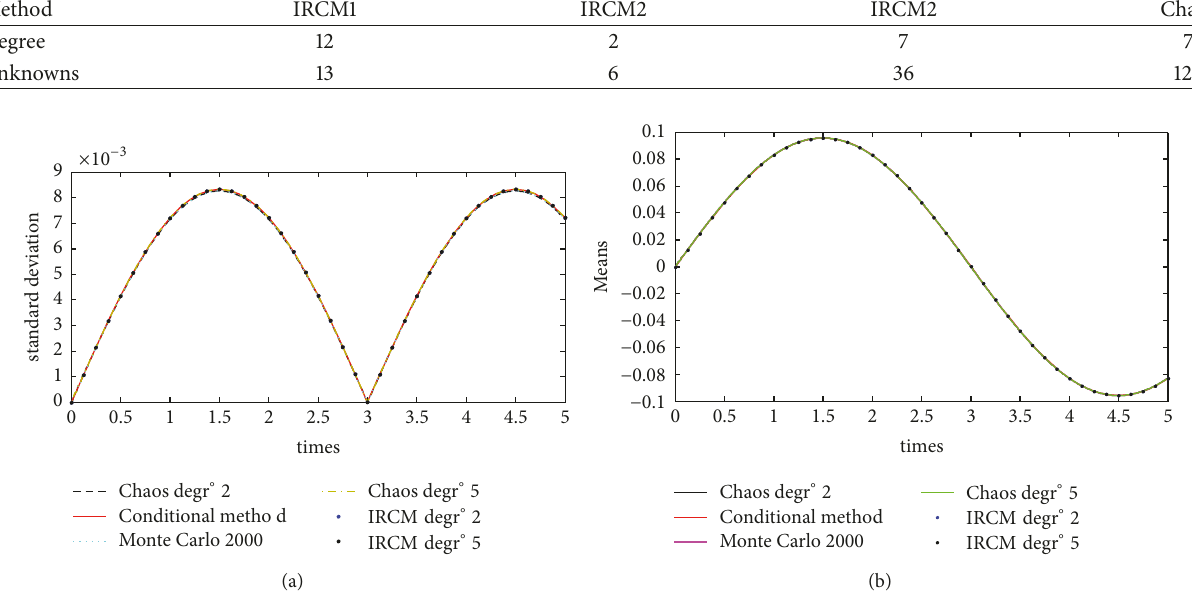
[0, 10] and 𝜎 𝑖 = 5%. (b) Means of solution where [−1,1] , and 𝜉 3 is a truncated exponential variable in